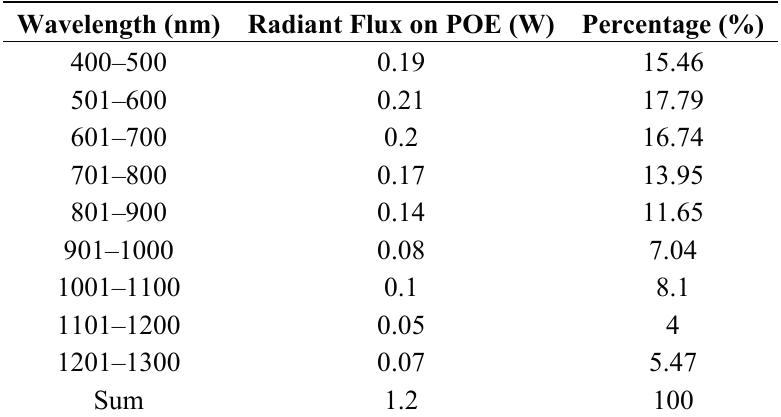
Table 5. Radiant flux for broadband spectral